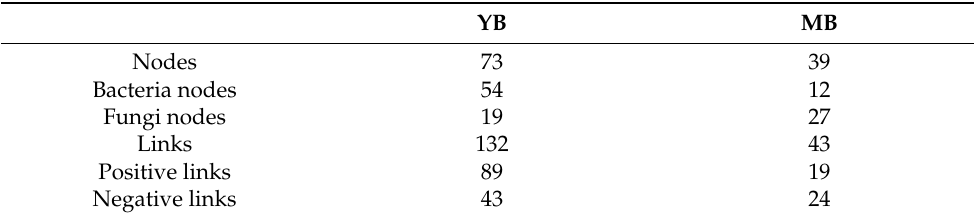
Table 1. Network topological features of young and mature branches of Nitraria tangutorum .